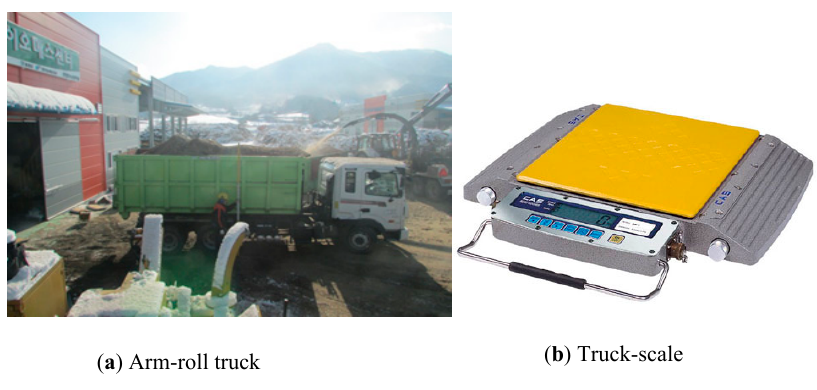
Figure 3. Weighing equipment for the wood chips.